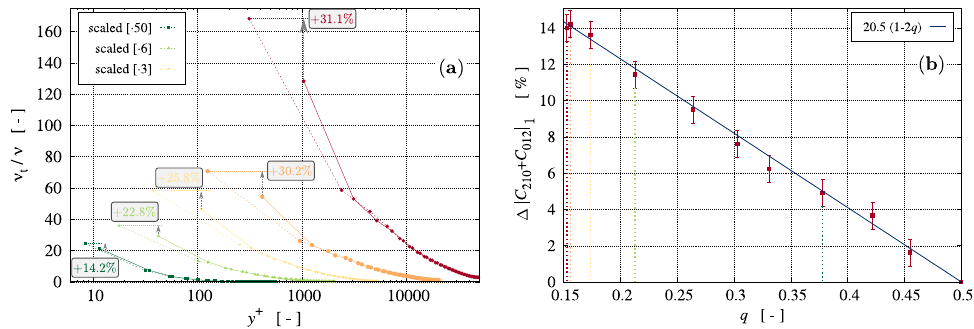
Figure 4. ( a ) Comparison of the normalized predicted (averaged) eddy viscosity obtained from a centered wall location ( q = 0.5; solid lines) and an adjusted wall location (dotted lines) for Re τ = { 550, 2000, 5200, 20,000, 50,000 } on the N H = 24 grid. ( b ) Increase in the (averaged) cumulant expression | C + C | 210 012 1 at the first fluid node as a function of the wall location parameter q bars refer to ∆ | C 210 + C 012 | 1 ± 0.75%. Colored verticals correspond to the modified q -values on the N H = 24 grid in ( a ), whereas further data points refer to Re τ = 550 simulations employing N H = { 12,16,19,29,32 } from left to